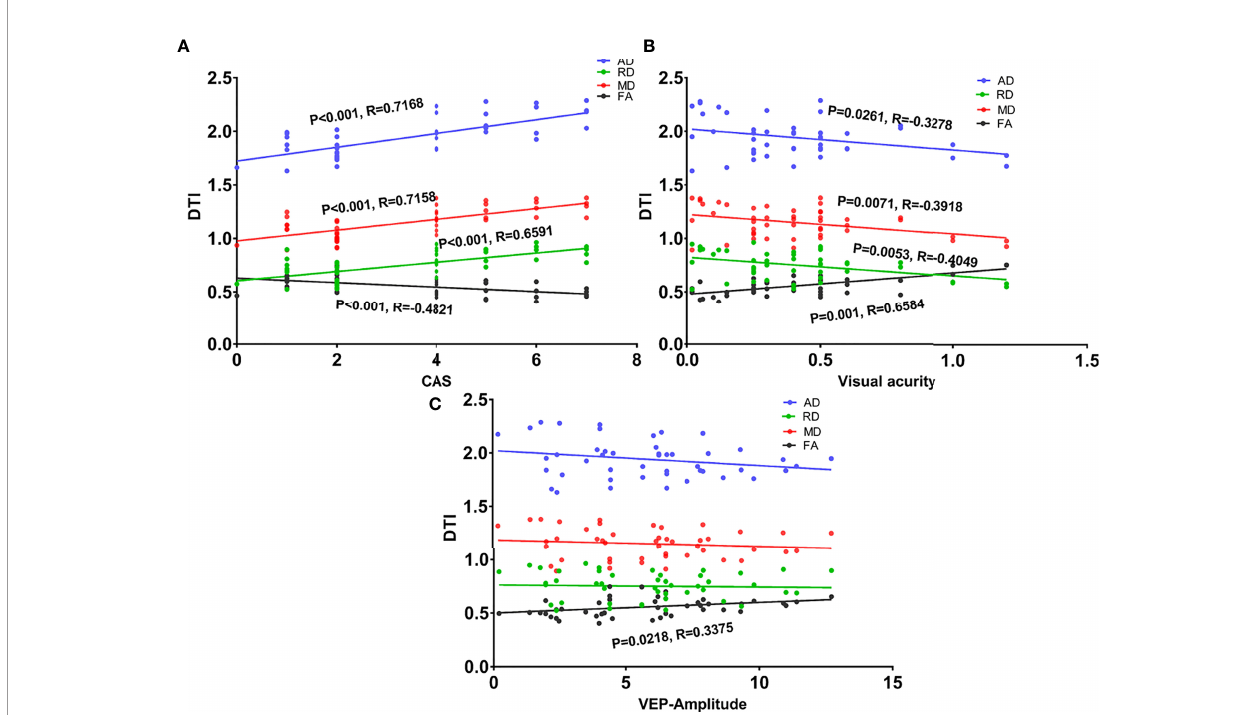
FIGURE 4 | Scatter diagrams showing signi fi cant correlations between clinical indexes and DTI values of the intra-orbital optic nerve in the dysthyroid optic neuropathy group. (A) The correlation between the four DTI parameters and clinical activity scores (CAS). (B) The correlation between the four DTI parameters and visual acuity. (C) The correlation between the four DTI parameters and the amplitude of visual evoked